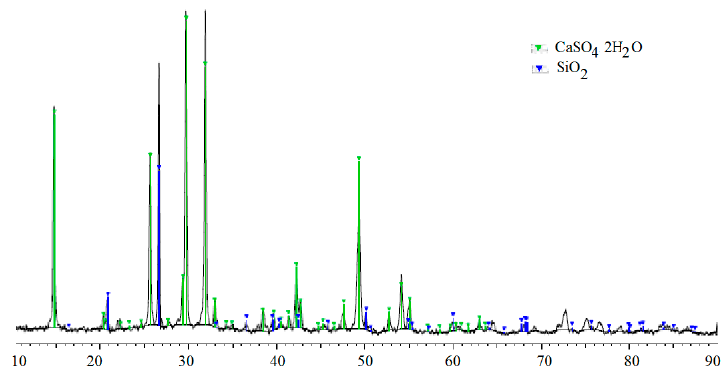
Figure 3. X-ray powder diffraction (XRD) diffractogram of the surface precipitates.